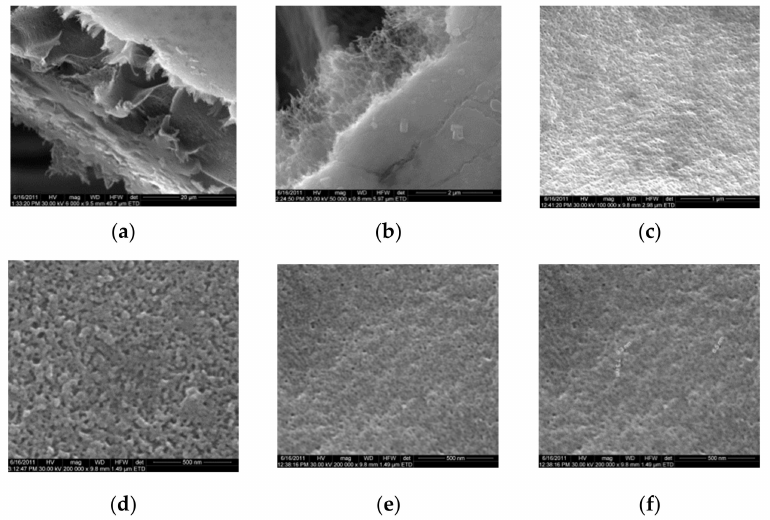
Figure 2. SEM images of a nanostructured polysulfone membrane ( a )—section, ( b )—section detail (active layer); ( c )—surface layer and component nanoparticles; ( d )—, ( e )—nanostructure of microporous layer details; and ( f )—dimension of the pores on the nanostructure